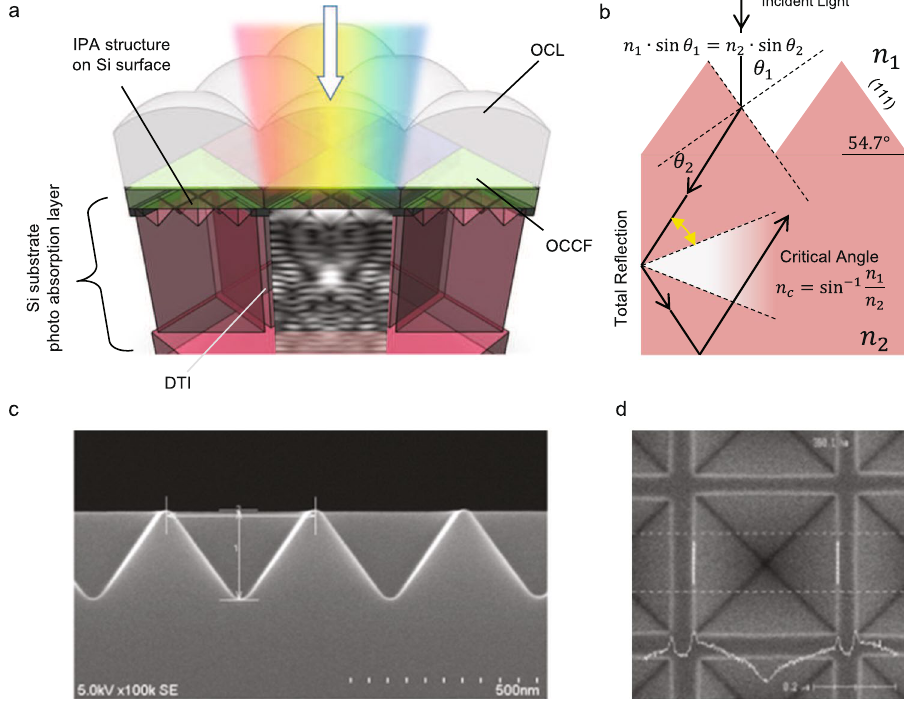
Figure 1. ( a ) A schematic image of the prototype BI-CIS pixels with the inverted pyramid array structures (IPA) and deep trench isolation (DTI). Each pixel equips on-chip micro lens (OCL) and RGB on-chip color filter (OCCF) in Bayer format. At the bottom of each pixel, there are CMOS transistors to readout collected carriers, which are not illustrated for simplicity. ( b ) A schematics of light rapping pixel concept. Normal incident light has the incident angle θ 1 . It is refracted with the angle of θ 2 following Snell’s law. The refracted light is totally reflected at the pixel sidewall in case that the angle is larger than the critical angle. As a result, the effective optical path length elongate with in the Si substrate. ( c , d ) SEM cross-section and top-view images of c-Si with the